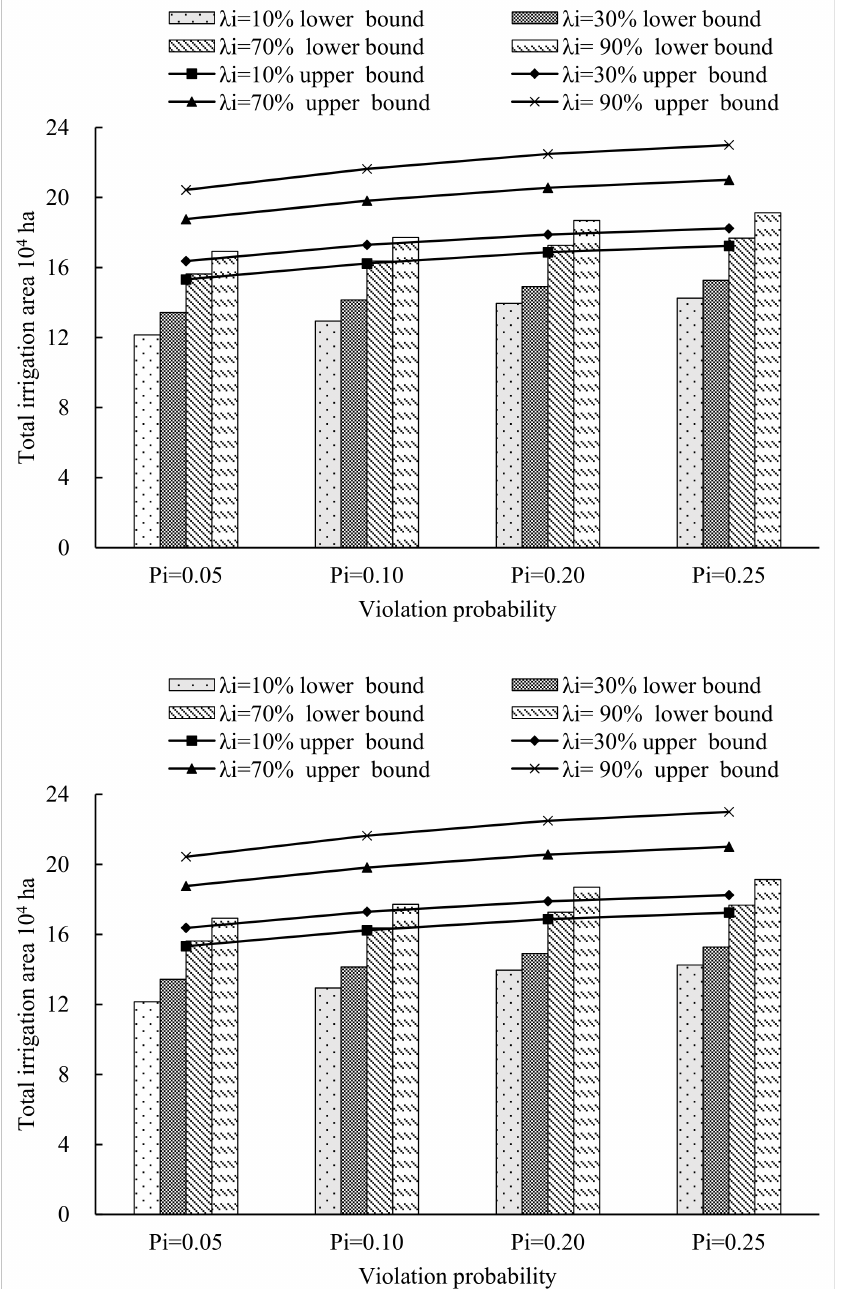
Figure 4. Thetotalirrigationareaofdifferentwater-savingmodesunderdifferentviolationprobabilities, P i